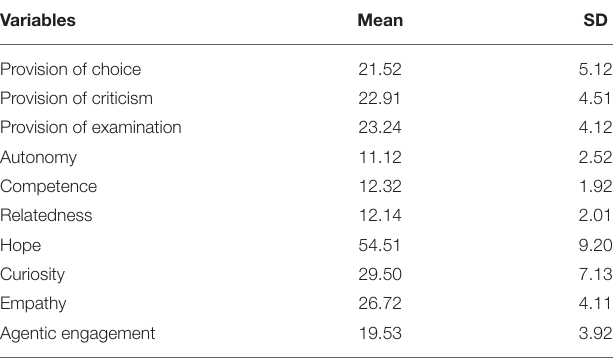
TABLE 1 | Mean and standard deviation of research